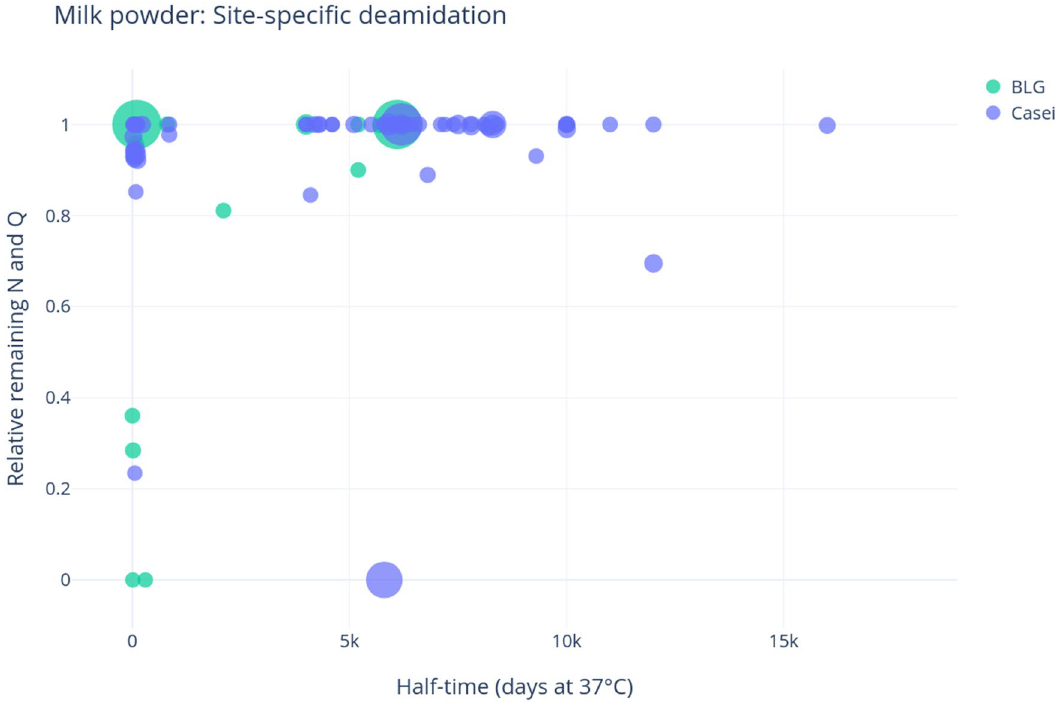
Figure 2. Site-specific deamidation of milk powder proteins. The y-axis shows the relative remaining portion of the deamidating amino acid, while the x-axis represents the half-time of the sites of deamidation. The size of the points is relative to the intensity of the peptide identified. Half-times as estimated by Robinson and Robinson 26 , plots produced through deamiDATE 24 .